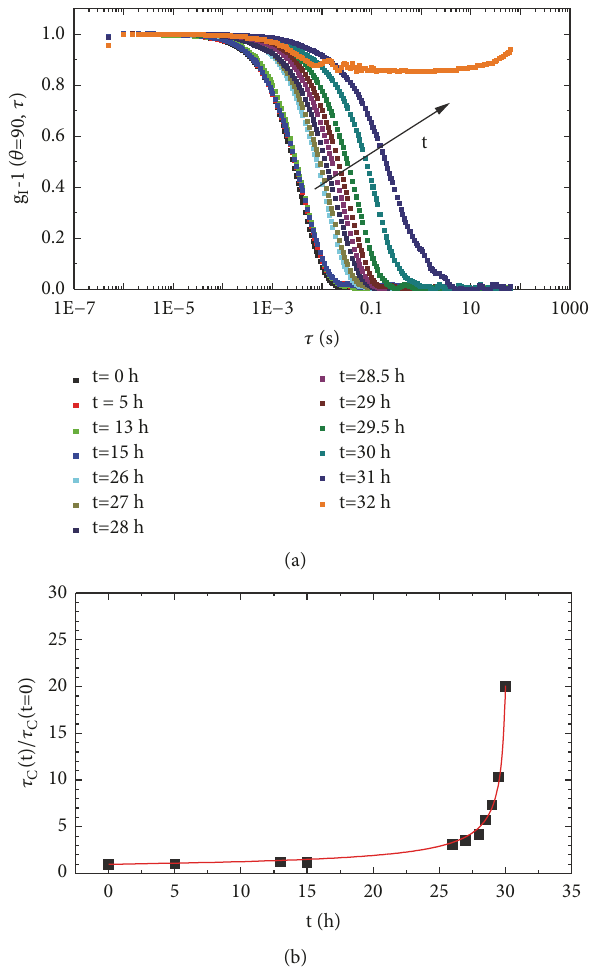
Figure 4: (a) Intensity autocorrelation function minus one mea- sured as a function of time. (b) Ratio of the characteristic times obtained from the analysis of the autocorrelation functions shown in (a) normalized by the initial decay time measured at t = 0h. Line is a fit to a critical power law: 𝜏 𝐶 (𝑡)/𝜏 0 = (1 − (𝑡/𝑡 𝑔𝑒𝑙 )) −𝑠 , where 𝜏 0 is the decay time of the autocorrelation at time t =0 h and t fitting